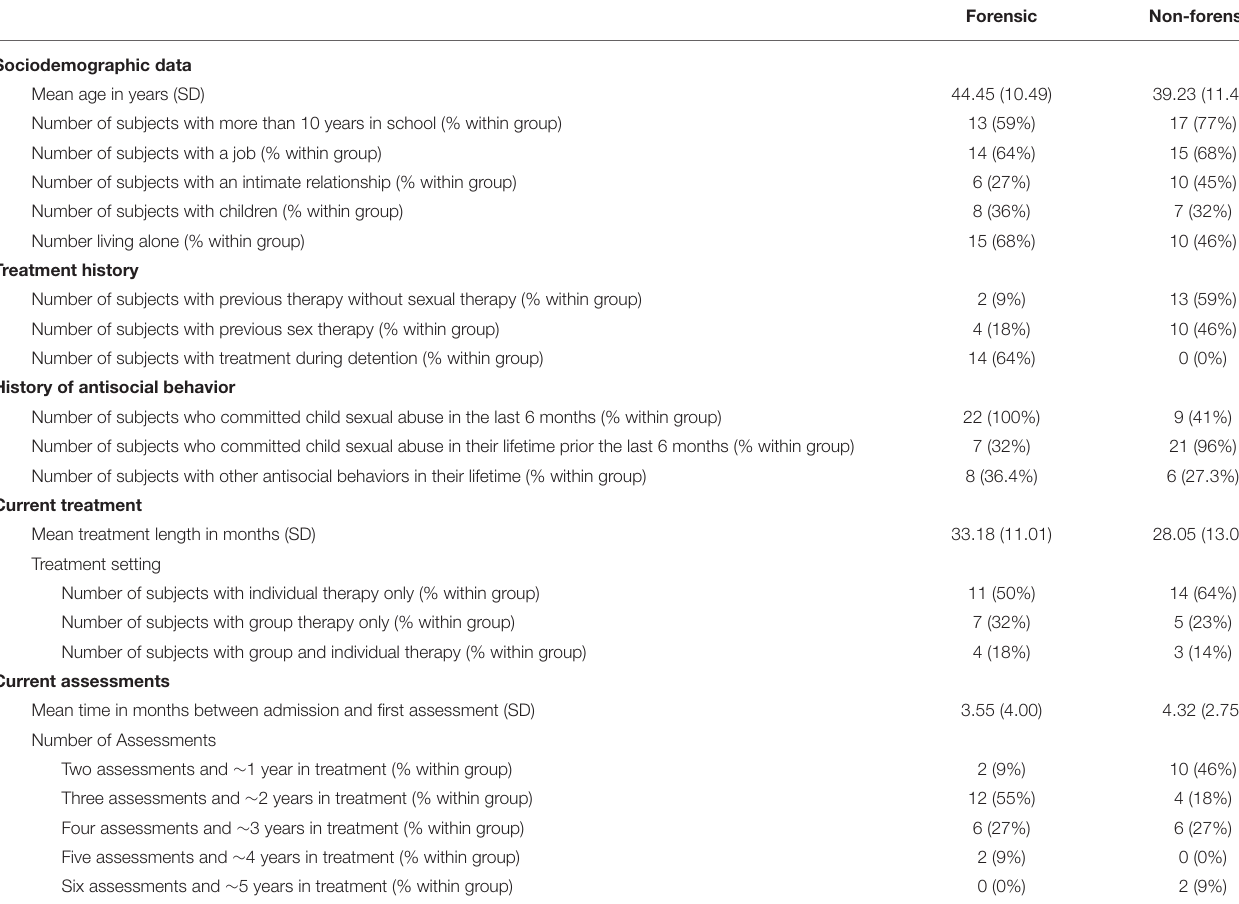
22) and non-forensic clients ( n =